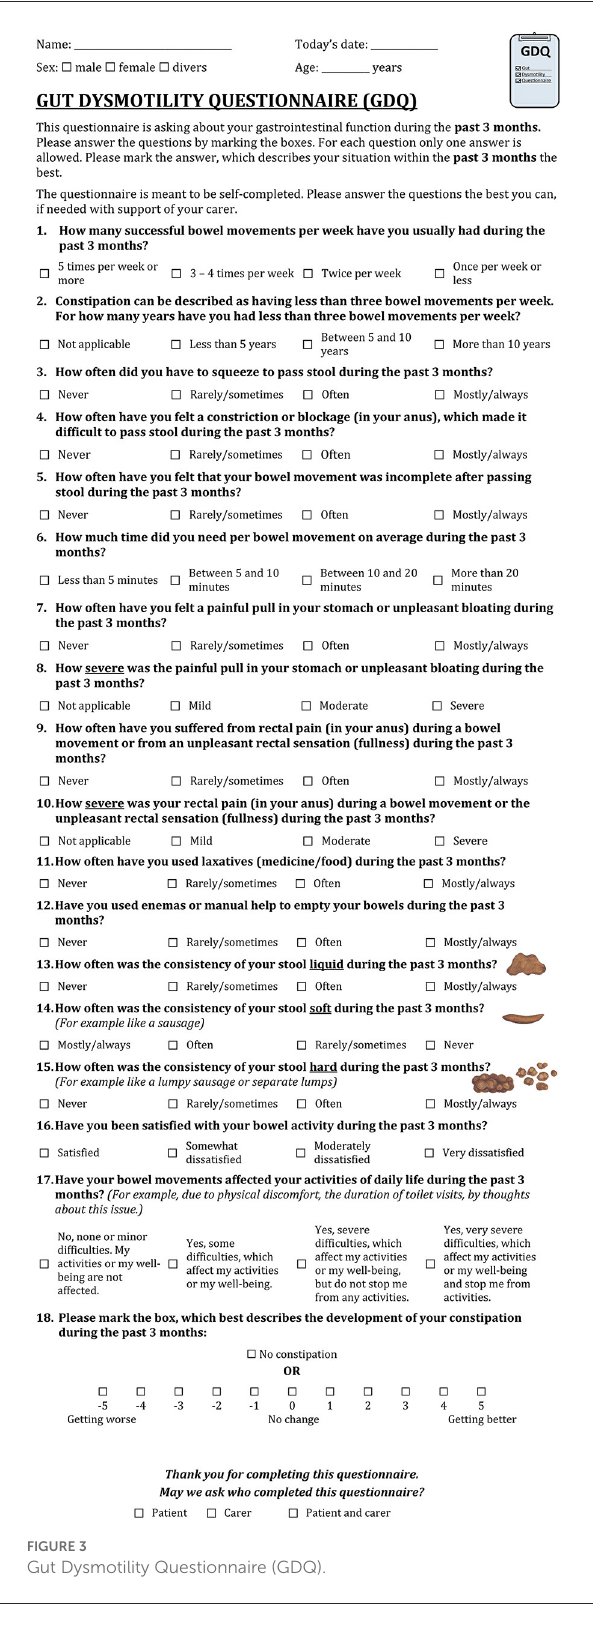
TABLE 7 Domains of the final GDQ with corresponding